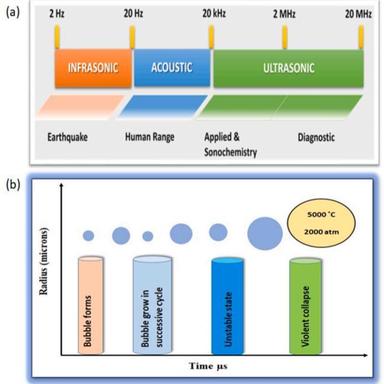
(a) Various frequency ranges of ultrasound waves, and (b) the evolution of the micro-sized cavitation bubbles during a sonochemical process.